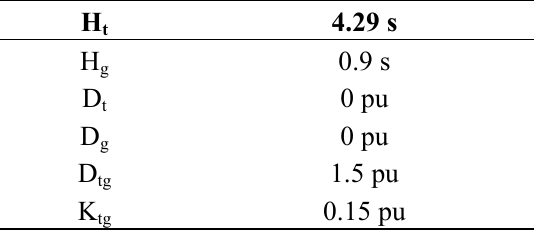
Table A2. Parameters of the shaft